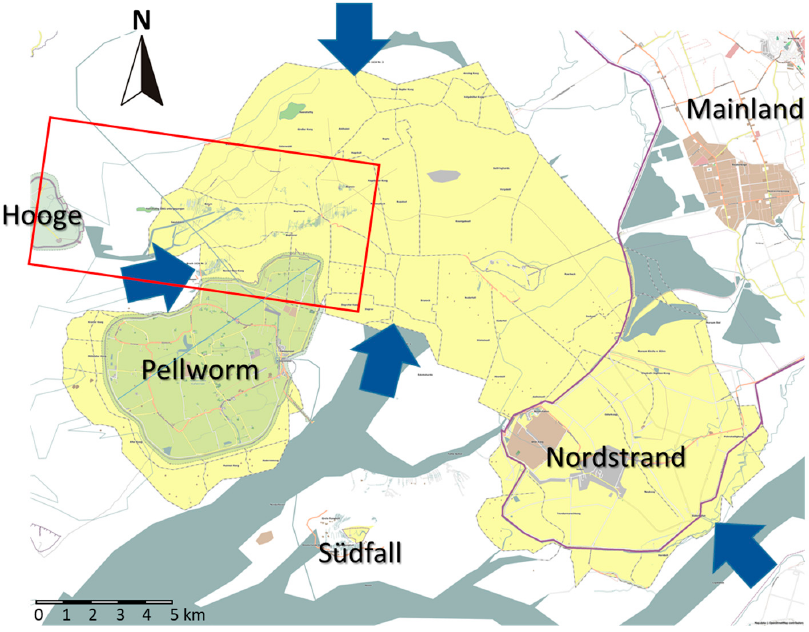
Figure 4. Map showing in yellow the former Island of Strand, and in green today’s islands Pellworm and Hooge. The mainland and Nordstrand are located on the right. Locations of residuals of former landuse, along with roads, dikes, and names of former settlements are also inserted. The blue arrows denote those main locations, at which the dikes broke in 1634, and the red rectangle denotes the locations of the SAR image shown in Figure 3. Map: C. Kost.